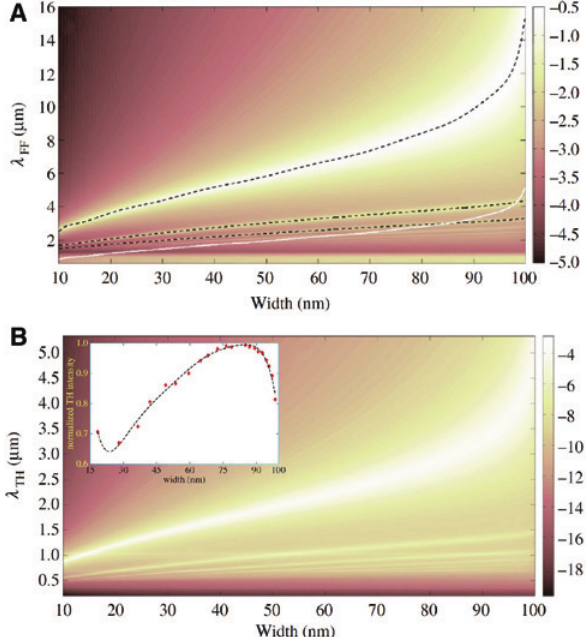
Figure 16: Linear and nonlinear responses of graphene ribbons. (A) linear absorption spectra at FF versus the width of graphene ribbon and (B) nonlinear radiation intensity spectra at TH versus the width of graphene ribbon. Reproduced from Ref.